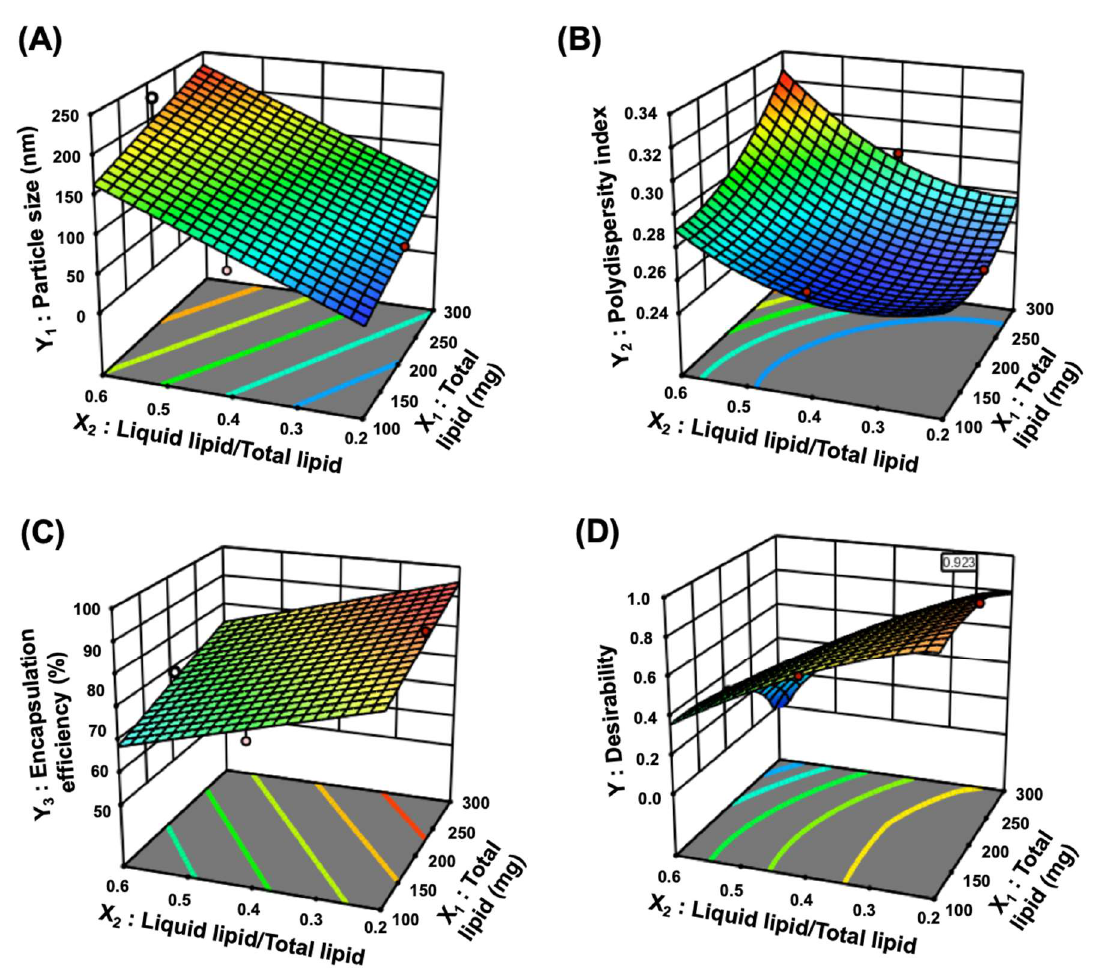
Figure 2. 3D surface plots of ( A ) Y 1 : Particle size, ( B ) Y 2 : Polydispersity index, ( C ) Y 3 : Encapsulation efficiency, and ( D ) Y: Desirability value. The X 3 (percentage of surfactant) was set to 1 w / v %. The optimal factors were determined using the desirability function reflecting all